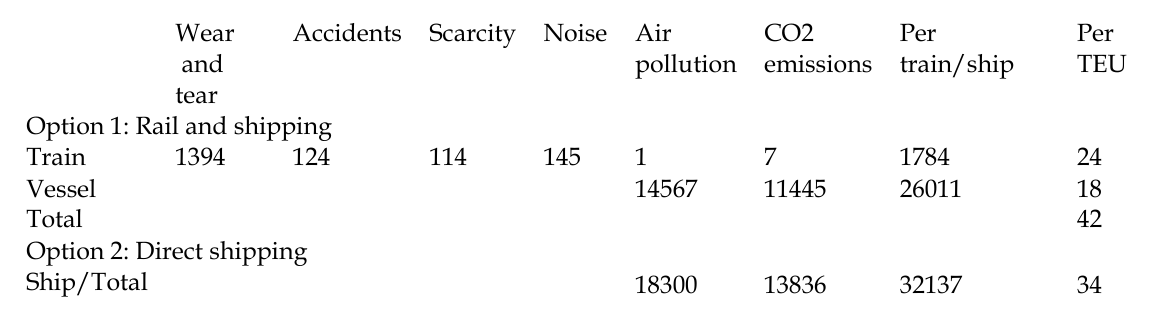
Table 4. Social costs of the two options (in €) based on Swedish guidelines Wear Accidents Scarcity Noise Air and tear Option 1: Rail and shipping Train 1234 58 0 341 Vessel 23942 Total Option 2: Direct shipping Ship/Total